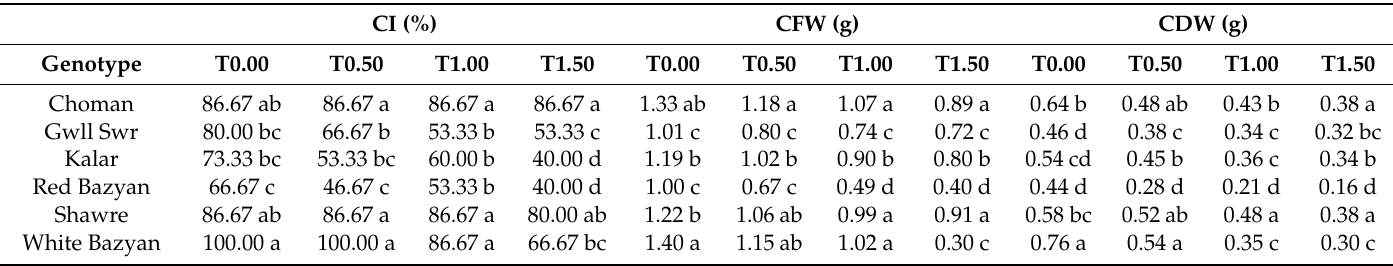
Table 5. E ff ect of di ff erent concentrations of PEG on the callus morphology and dimension. The numbers given are the mean values calculated for the three measurements obtained for PEG concentrations (0.00% (T0.00), 0.50% (T0.5), 1.00% (T1.00), and 1.50% (T1.50)) for each genotype. CL: Callus Cell Length, CW: Callus Cell Width and CWT: Callus Cell Wall Thickness. The similar letters within a column suggest no significant variation between mean values, according to Duncan test ( p ≤ 0.05). CL ( µ m) CW ( µ m) CWT ( µ m)